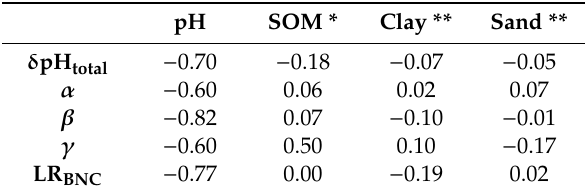
Table 5. Standardized regression coe ffi cients (SRC) BNC parameters and the soil acidity and pH bu ff er capacity a ff ecting soil properties pH, SOM, Clay and sand. Numbers in brackets indicate the sensitivity ranking.